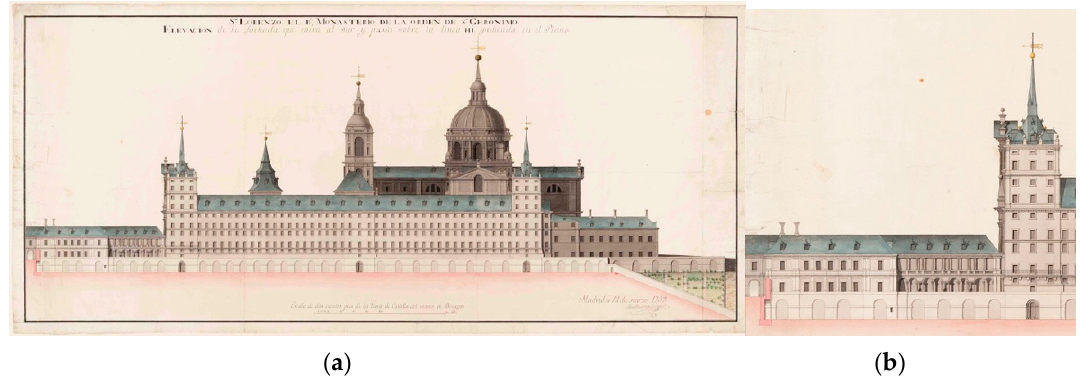
Figure 13. Bernardo Fillera and Balthazar Bécaud, 1759: San Lorenzo el R l Monasterio de la orden de S n Geronimo. Elevacion de la Fachada que mira al sur y passa sobre la linea HI yndicada en el Plano. ( a ) South elevation of the Monastery. ( b ) Detail of the façades of the Botica and the Galería de Convalecientes facing to the orchard. Canadian Centre for Architecture, Montréal, DR1986:0725.